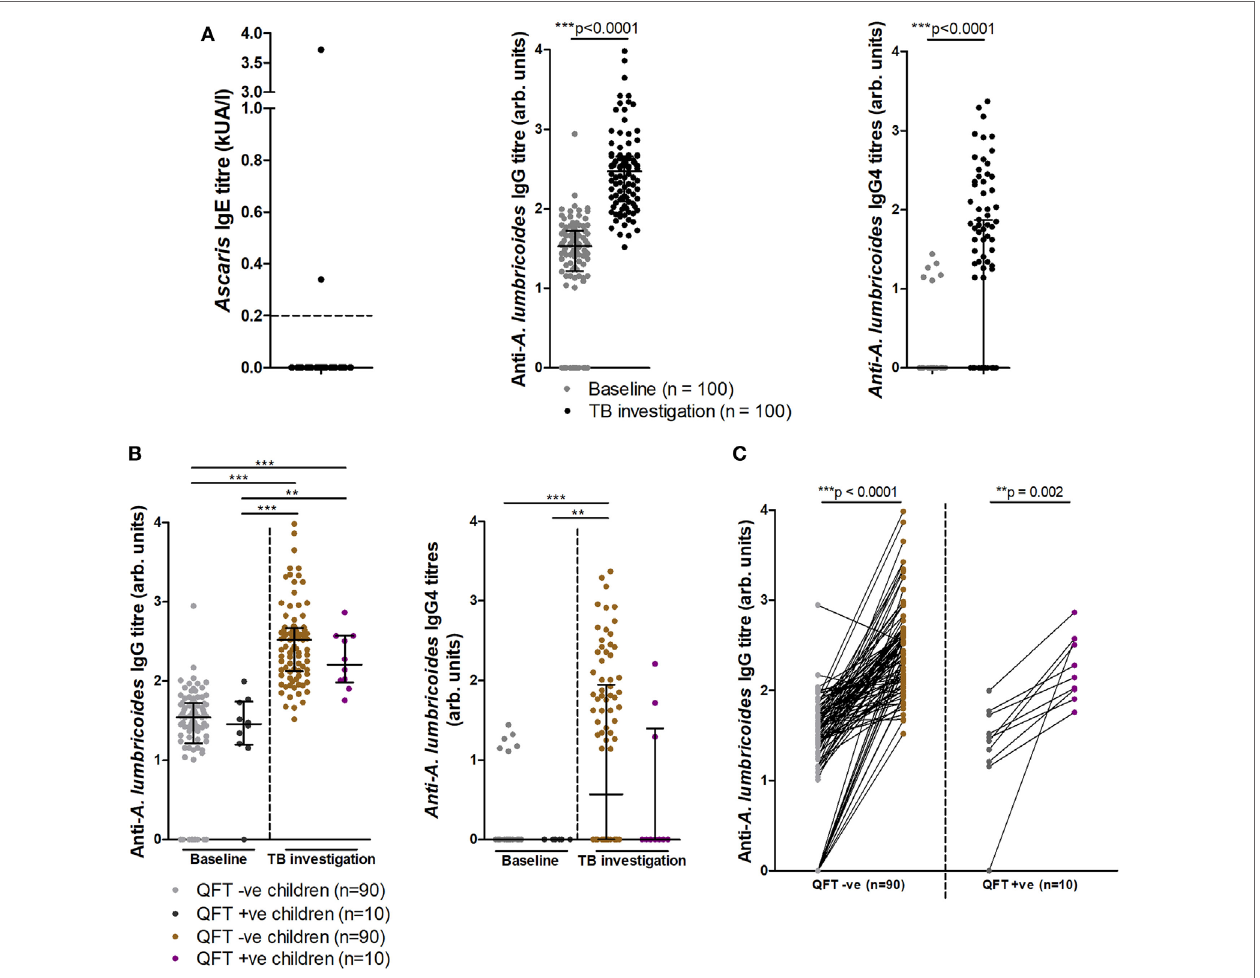
FigUre 5 | Soil-transmitted helminth-specific IgG titers and QFT outcome at baseline and upon tuberculosis investigation. Anti- Ascaris lumbricoides IgE ( n = 50) , IgG, and IgG4 ( n = 100) titers (a) . Anti- A. lumbricoides IgG and IgG4 titers stratified by QFT outcome (B) . A before/after comparison of anti- A. lumbricoides IgG titers as subdivided in (B) is presented in (c) . Antibody titers are presented as arbitrary values. The Mann–Whitney test was used to assess two-group comparisons for significance in (a) , the Kruskal–Wallis test with Dunn’s post hoc test was used for the multi-group comparisons in (B) , and the Wilcoxon matched-pairs signed rank test was used to assess for significance in (c)